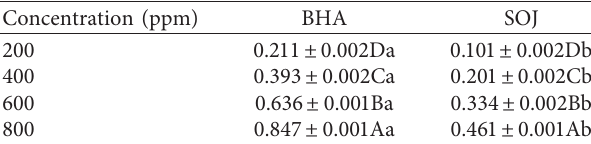
∗ Data represent mean ± standard deviation of three independent repeats. ∗∗ Different capital letters in each column and lowercase ones in each row indicate significant differences ( p < 0 . 05 )